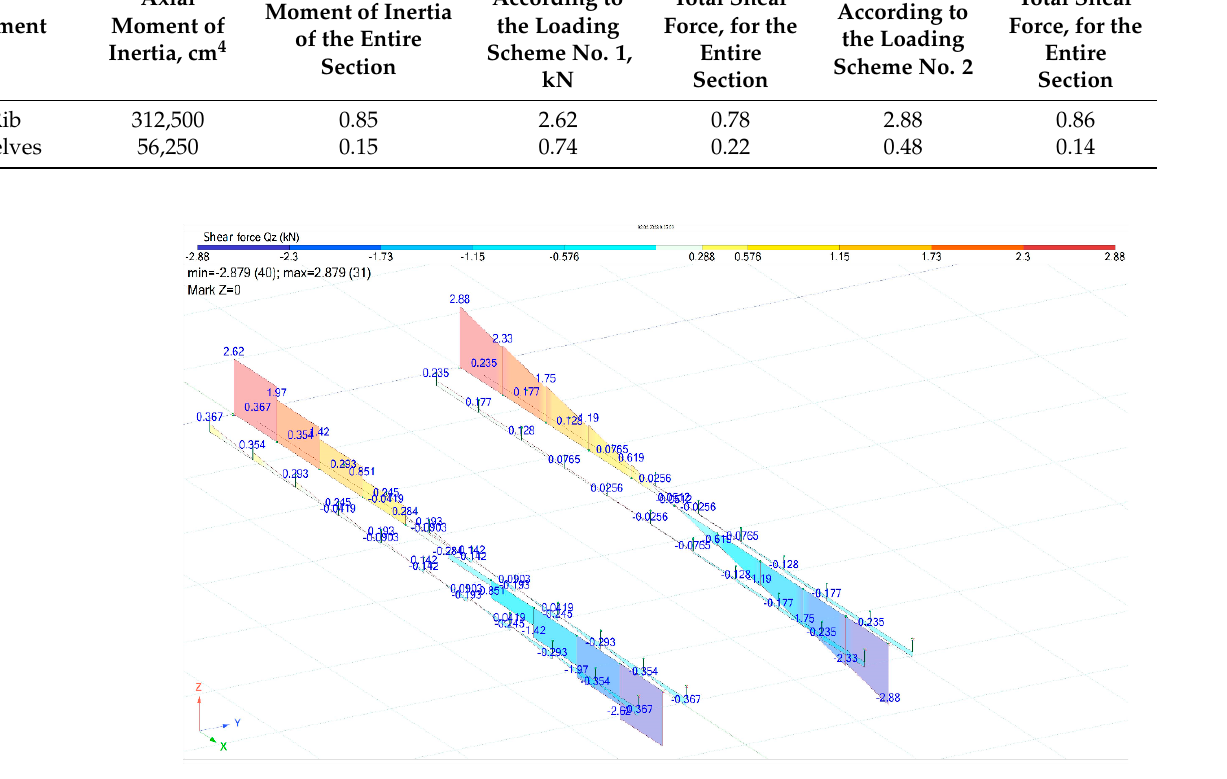
Figure 11. Shear force diagrams in the vertical rib and flanges. It can be seen that the side shelves perceive part of the shear force. The stepwise or linear character of the change in the transverse force, as well as its value, depends on the place of application of the load. Table 2. Summary table of calculation results.